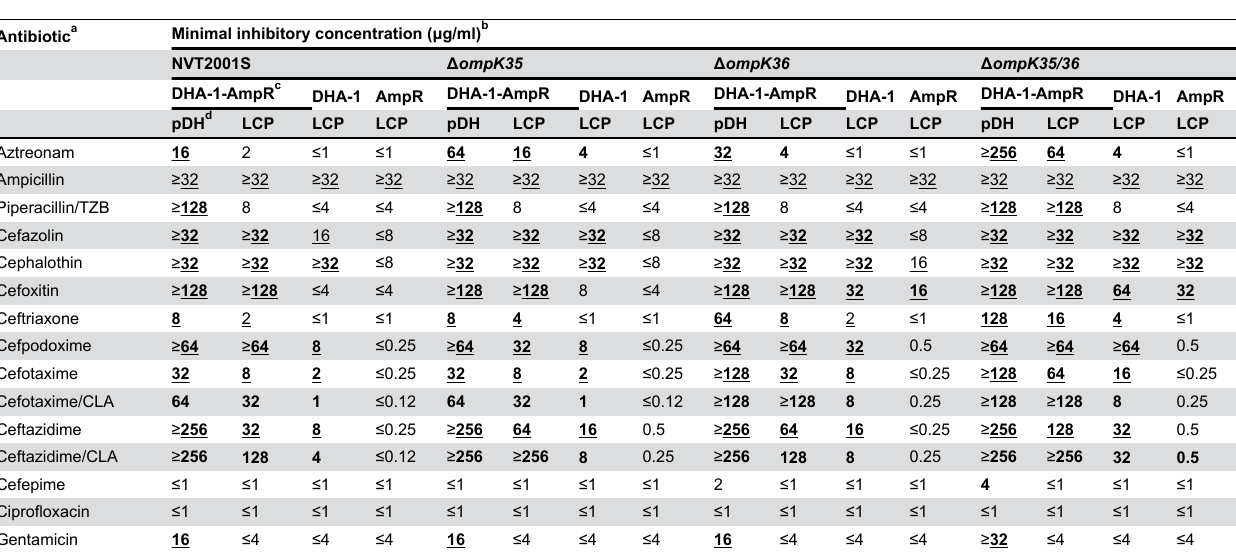
Table 4. MICs of antibiotics against K. pneumoniae NVT2001S and its porin-loss mutants with AmpC β-lactamase and/or its